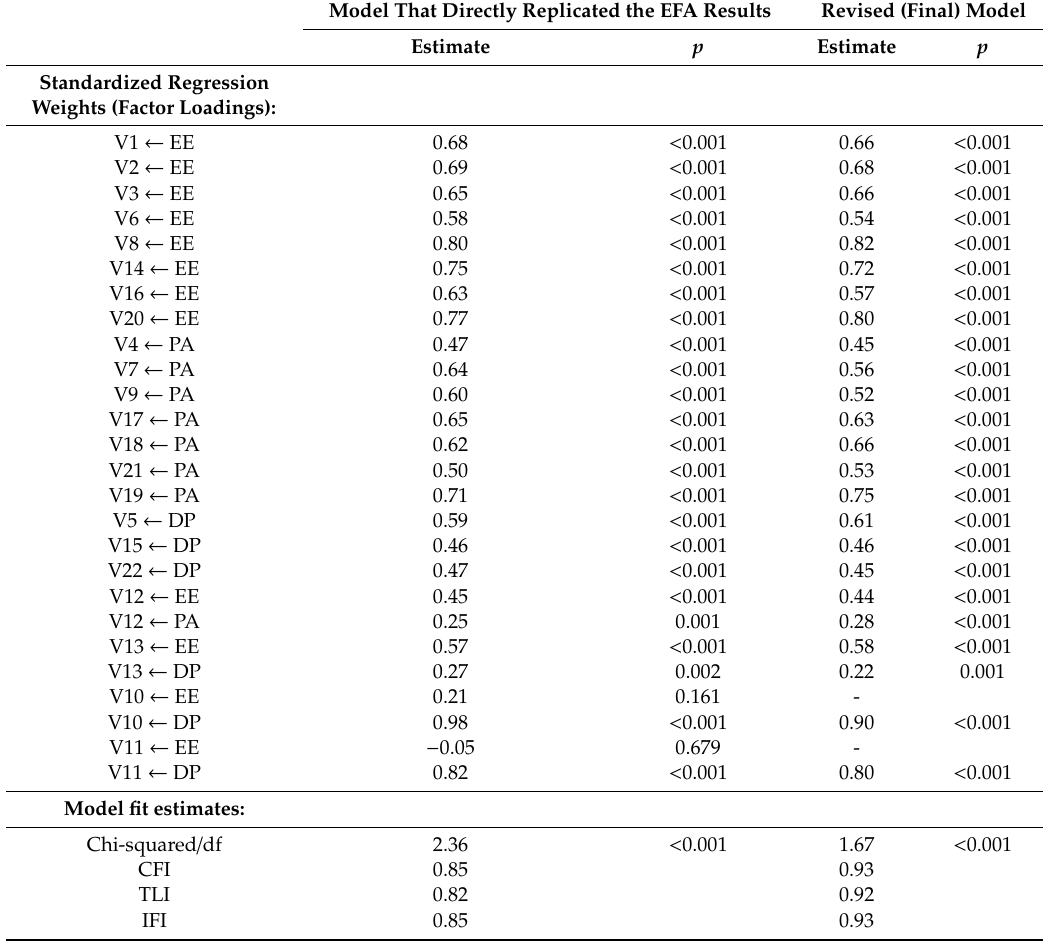
Table 4. Estimates of three-factor model of the Maslach burnout inventory obtained from the confirmatory factor analysis of randomly selected subgroup 2 of the entire sample ( N = 190). Model That Directly Replicated the EFA Results Revised (Final) Model Estimate p Estimate p